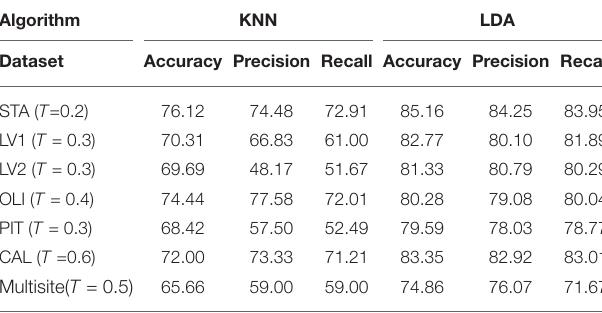
TABLE 5 | Classification performance on our data cohorts by using the five community pattern descriptors as features with KNN and LDA algorithms. Algorithm KNN LDA